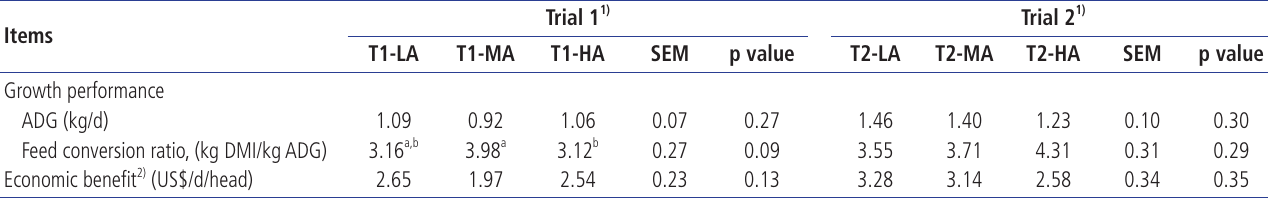
Table 4. Growth performance and economic benefit of Simmental beef calves with different levels of alfalfa hay in their diets